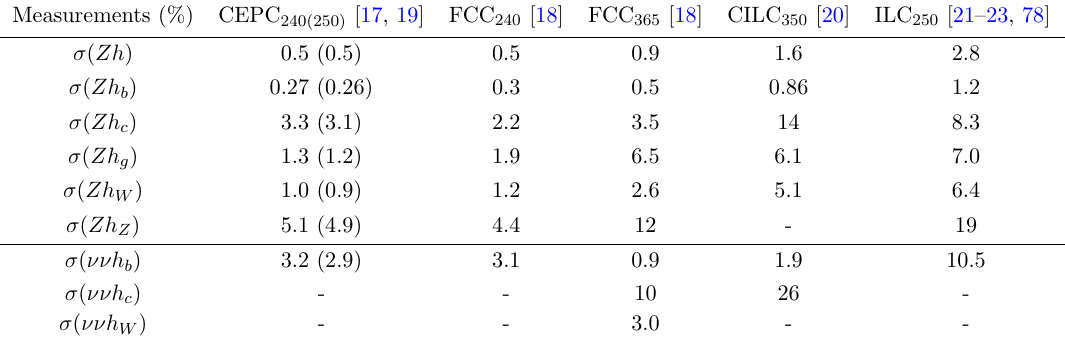
Table 3 . Expected precisions of measuring O i at e (cid:0) e + colliders. The CEPC 240 precisions are extrapolated from the CEPC 250 ones (inside the parentheses) [17, 19]. The ILC 250 results are based on its previous baseline luminosity (250 fb (cid:0) 1 ).